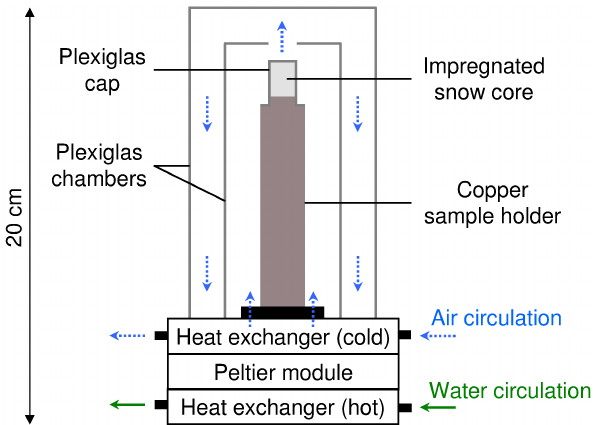
Figure 2. Illustration of the cryogenic cell used during the tomo- graphic